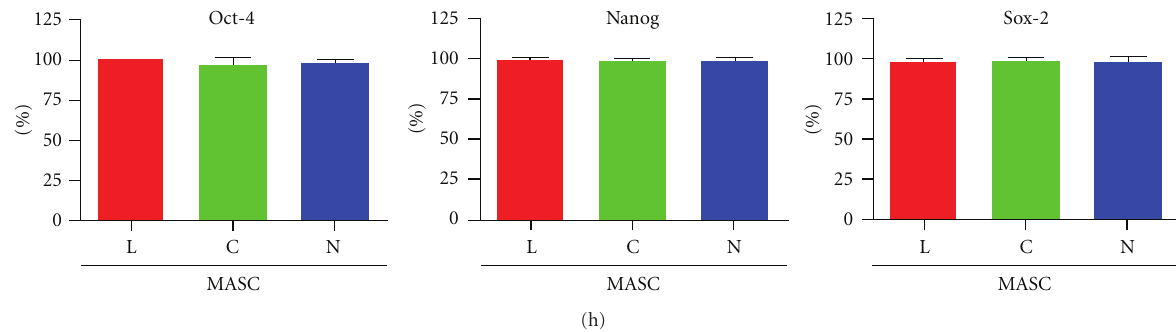
Figure 2: Pluripotent state-specific transcription factor expression. (a) Representative RT-PCR analysis of Oct-4, Sox-2, Nanog, and GAPDH mRNA transcripts in N-MASCs. The right lane of each gel is the negative control (H 2 O). (b–g) Oct-4 (green fluorescence; (b–c)), nanog (red fluorescence; (d, e)), and sox-2 expression (yellow fluorescence; and (f, g)) in the nuclei of C-MASCs. Nuclei are depicted by the blue fluorescence of DAPI staining (c, e, g). (h) Quantification of pluripotent state-specific transcription factor expression. Data are presented as mean ± standard deviation.